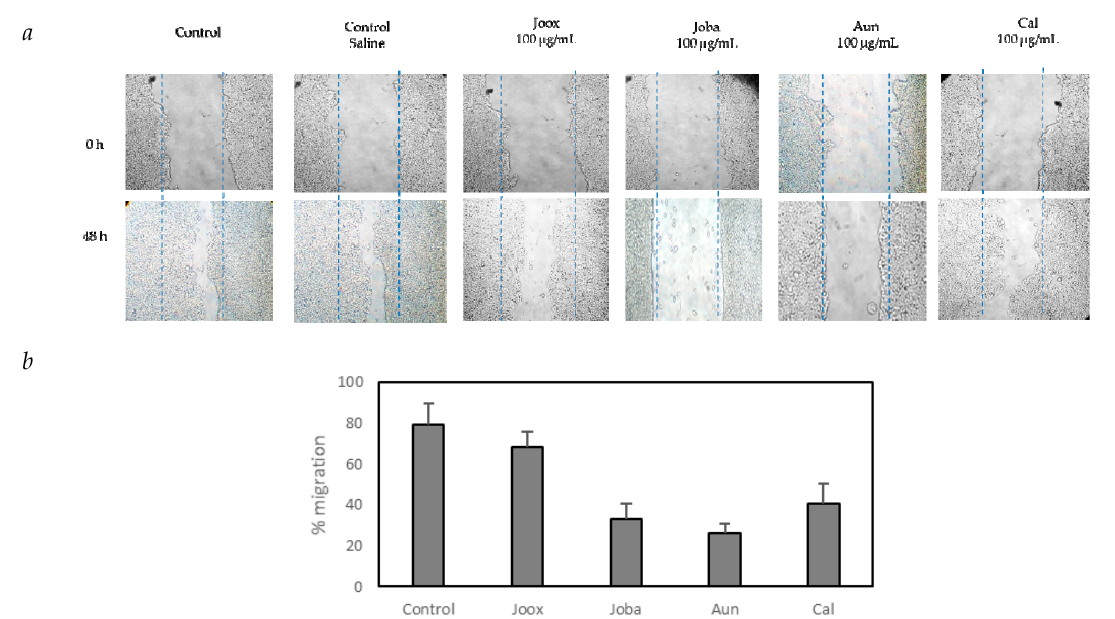
Figure 2. HT29 cell migration after exposure to total soluble protein extracts of Juniperus oxycedrus subsp. oxycedrus (Joox), Juniperus oxycedrus subsp. badia (Joba), Arbutus unedo (Aun) and Corema album (Cal), as determined by migration assays. Cells were grown until reaching 80% confluence and the monolayer was scratched with a pipette tip (day 0). Cells were then exposed to 100 µg protein mL − 1 protein extract and cell migration was recorded after 48 h ( a ). The histogram reports the relative migration rates, where values are the means of at least three replicate experiments ± SD and are expressed as % wound closure in relation to day 0 ( b ).